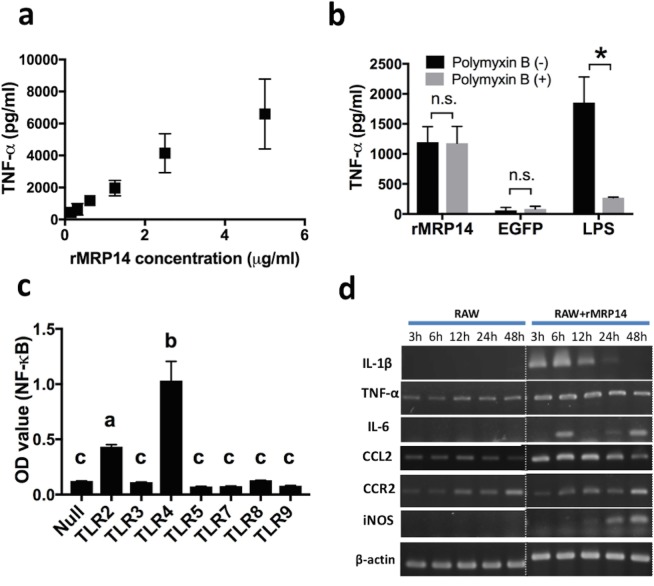
Macrophage activation induced by rMRP14.(a) Increase of TNF-α secretion dependent on rMRP14 concentration in RAW264.7 cells. RAW264.7 cells (2 x 105 cells/ml) were stimulated by rMRP14 (0.15–5 µg/ml) and the concentration of secreted TNF-α in supernatant was measured by ELISA. (b) The increase of TNF-α by rMRP14 could not be blocked by addition of polymyxin B. RAW264.7 cells (2 x 105 cells/ml) were stimulated by rMRP14 (100 ng/ml), EGFP (100 ng/ml) or LPS (2.5 ng/ml) incubated with or without polymyxin B (50 μg/ml), which is a LPS inhibitor. EGFP is recombinant proteins with polyhistidine-tag, which was used as a negative control. (c) MRP14 as an agonist of TLR2 and TLR4. HEK293 cells transfected with murine TLR gene were stimulated by rMRP14 (5 µg/ml) and SEAP induced by NF-κB activation through TLR was measured. Different letters on the bars represent statistical difference between groups. (d) mRNA expression of IL-1β, TNF-α, IL-6, CCL2, CCR2, iNOS and β-actin in RAW264.7 cells (2 x 105 cells/ml) stimulated by rMRP14 (5 µg/ml). Graphs show mean and SD of triplicates. Data are representative of three independent experiments. *P < 0.05; n.s., not significant.